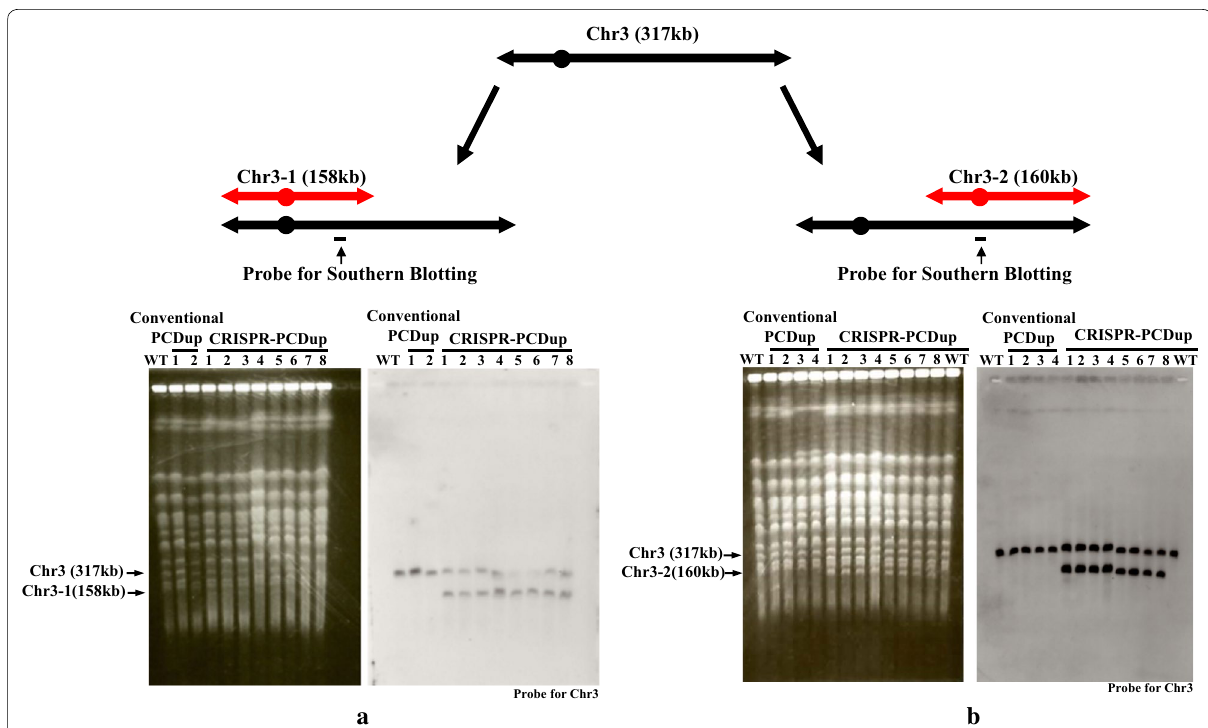
Fig. 2 Duplication of the Chr3-1 and Chr3-2 region. The Chr3-1 and Chr3-2 regions of Chromosome 3 were chosen for the initial experiments. Both duplicating modules were prepared so as to be marked with CgHIS3 and CEN4 CgHIS3, respectively. After transformation, two chromosomes of 158 + kb (Fig. 2 a ) and 160 kb (Fig. 2 b ) were expected to be generated from Chr3-1 and Chr3-2, respectively. The left and right panel of Fig. 2 a and Fig. 2 b are PFGE along with the corresponding Southern blot analysis of wild type SJY30; 2 and 4 transformants selected from the conventional PCDup experiment for the Chr3-1 and for the Chr3-2 region, respectively and 8 transformants randomly selected from CRISPR-PCDup for both the Chr3-1 and Chr3-2 regions. Right panel of Fig. 2 a and Fig. 2 b shows the results of Southern blot analysis for detecting the 317 kb Chromosome 3 and newly duplicated 158 kb and 160 kb chromosomes, respectively